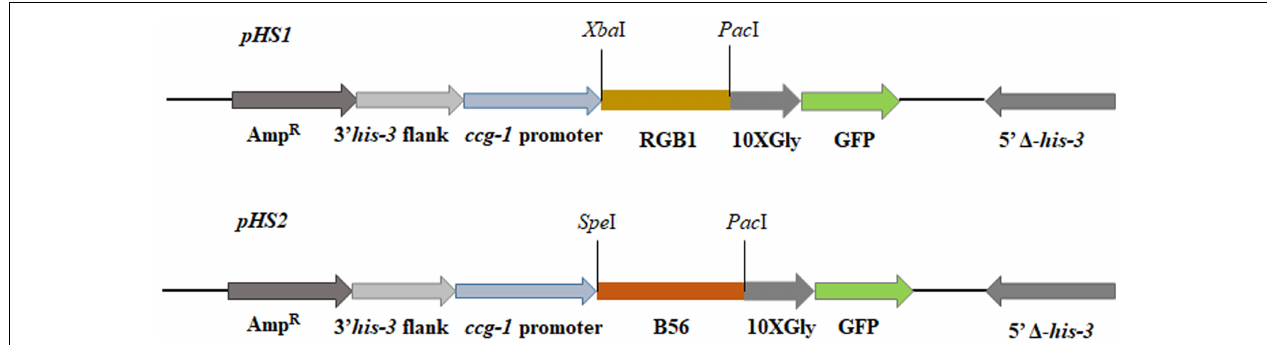
FIGURE 1 | pHS1 and pHS2, designed on the basis of the C-terminal epitope tag and gfp expression vector pCCG::C-Gly::GFP (Honda and Selker, 2009), used for GFP-tagging of RGB1 and B56, respectively.